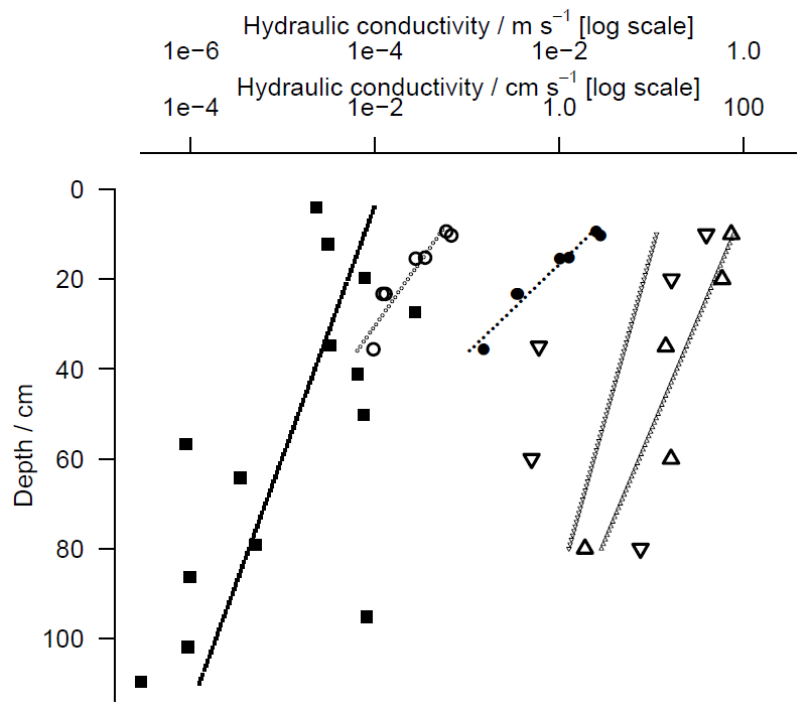
Figure 14. Relationship between hydraulic conductivity ( k ) and depth ( d ). Functional fitting to log ( k ) = b * d + a . From the left. Squares (one set of data): Beckwith et al . (2003), laboratory measurements of peat from Thorne Moors, Yorkshire, top 20 cm removed. Circles (two sets): Bragg (1982), field measurements at Dun Moss. Triangles (two sets): Holden & Burt (2003), field measurements at Moor House, about 1.5 km from the experiment area of the current report, but in a less humified peat. Filled symbols: horizontal component of conductivity; unfilled symbols both